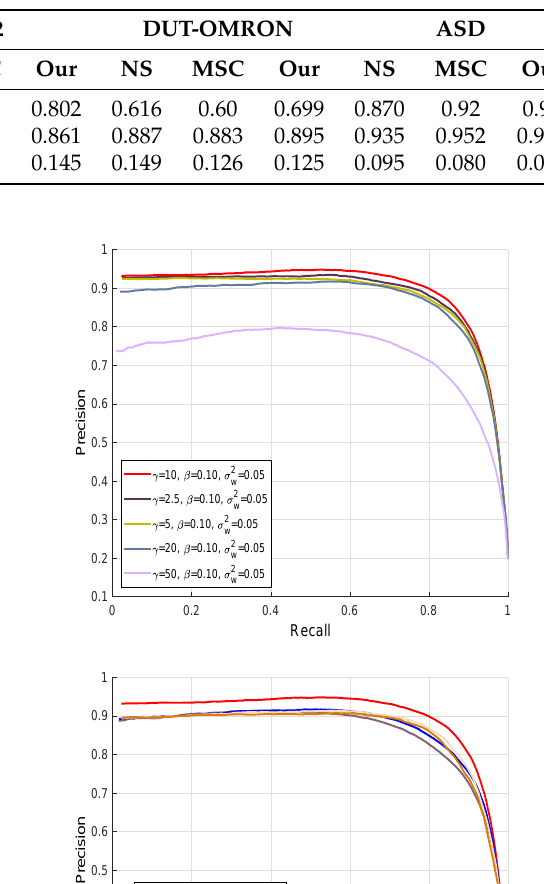
Table 1. The performance comparison of our model with recent schemes.